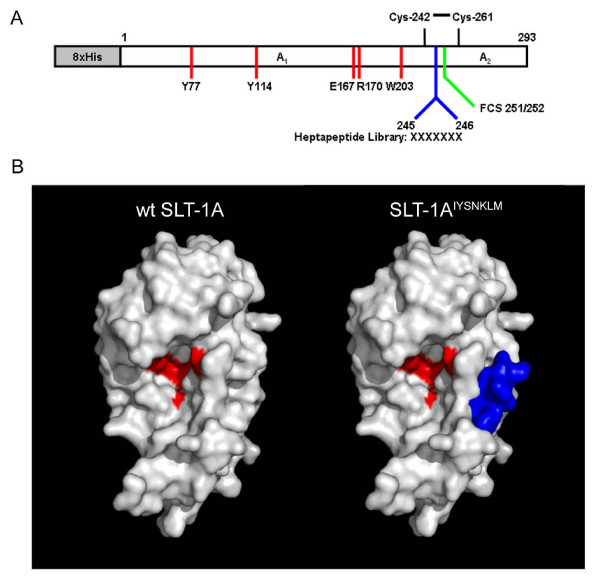
The scRIP SLT-1 A subunit served as a scaffold for the design and construction of an embedded 7-amino acid peptide combinatorial SLT-1 A subunit library. (A) Schematic diagram of the SLT-1 A subunit. Furin cleavage occurs within its protease-sensitive loop (C242 to C261) between residues 251 and 252 (FCS 251/252) of the A subunit [44]. A random 7-amino acid peptide library was inserted between residues 245 and 246, generating cytotoxic A subunit variants with a surface-displayed library insert. Catalytic residues are shown in red. (B) Modeled surface representations of the SLT-1 A subunit with and without a 7-residue long insertion. The models were derived from the crystal structure of Shiga Toxin [45]. The peptide insertion (blue) is solvent-exposed and positioned away from residues involved in catalysis (residues Y77, Y114, E167, R170, W203 colored in red) [20,46,47]. Models were rendered using PyMOL Software Version 1.0r1.